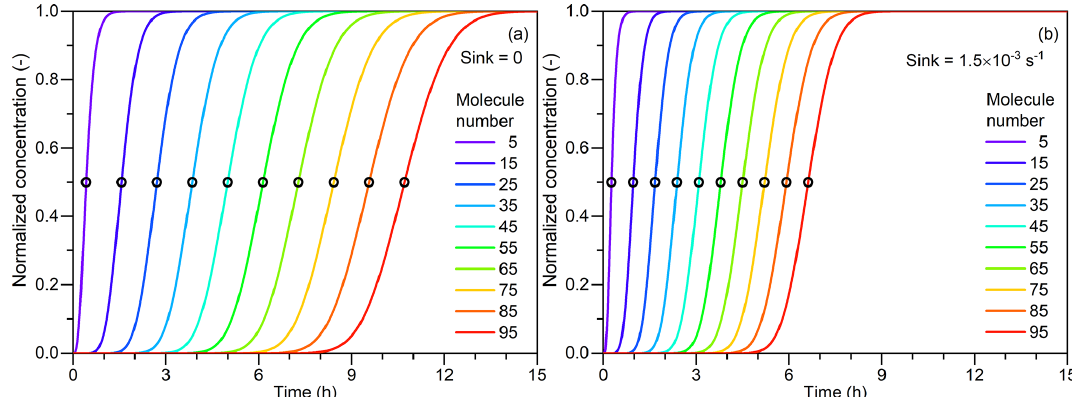
Figure 1. The principle of the appearance time method and the impact of the external sink. (a) Normalized particle concentrations as a function of time. The concentrations are normalized by dividing their corresponding maximum concentrations. The number concentration of the condensation vapor is assumed to be constantly 5 × 10 6 cm − 3 . Particle coagulation sink and other sinks are assumed to be negligible. Particle size is indicated by the molecule number contained in every single particle. The open scatterplots indicate the 50% appearance time corresponding to each particle size. (b) A constant external sink of 1 . 5 × 10 − 3 s − 1 is considered, and other simulation conditions are the same as in (a) . Note that due to the assumption of the size-independent coagulation coefficient, the appearance time in this figure deviates from its typical values in real new particle formation events. √ Table 2. The simulation conditions for Figs. 1 and 3–6. The symbol “ ” indicates “yes”, and the blank spaces indicate “no”. Figure Size-dependent External Coagulation Coagulation Vapor Constant vapor no. coagulation sink? sink? source? evaporation? concentration?